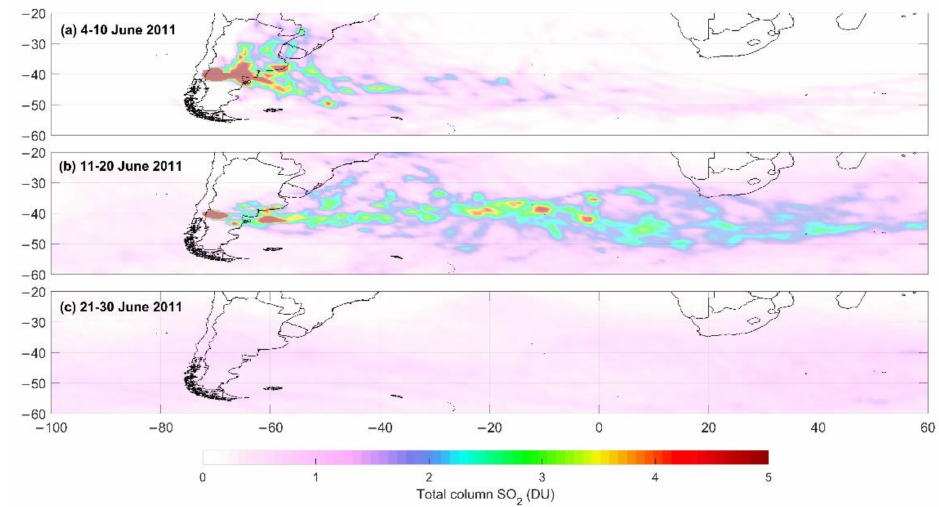
Figure 9. Composite image of flexible particle model (FLEXPART) SO 2 column for 4–10 June 2011 ( a ), 11–20 June 2011 ( b ) and 21–30 June 2011 ( c